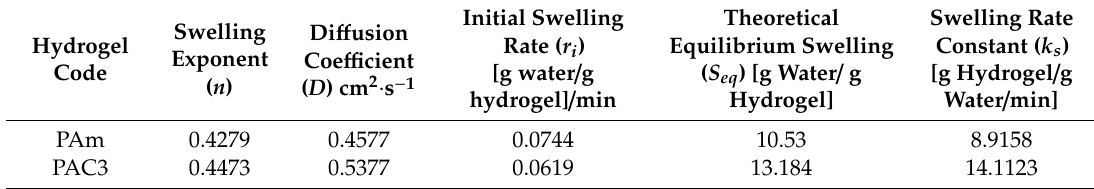
Figure 10. Swelling kinetics curves of PAm and PAC3 in DI water: ( A ) t / s verses t curves, ( B ) Ln S verses Ln t , and ( C ) swelling ratio verses t 1 / 2 curves. Table 2. Swelling kinetics parameters of PAC hydrogels.